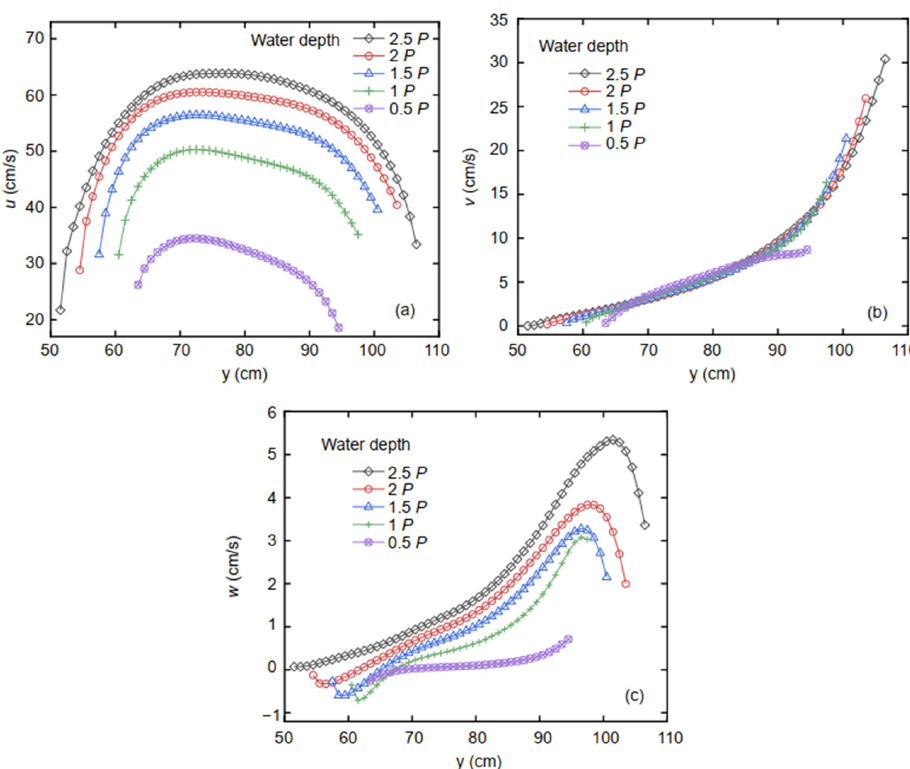
Figure 7. Velocity distribution at different water depths. Note: Q 1 = 40 L/s; b = 30 cm; P = 7 cm, which is the bottom sill height. ( a ) The x-direction with velocity u ; ( b ) the y-direction with velocity v ; and ( c ) the z-direction with velocity w .